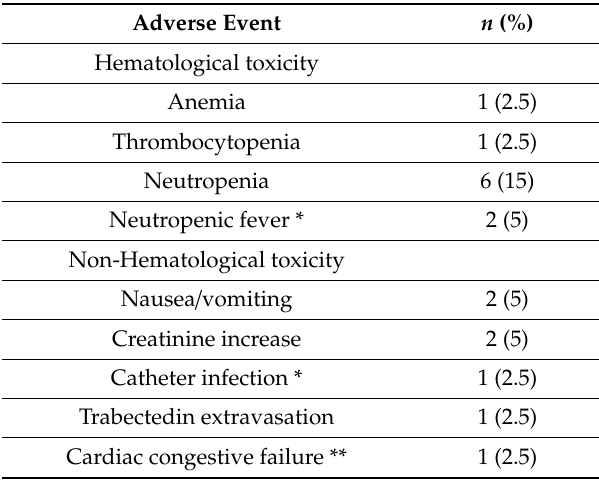
Table 2. Toxicity Grades 3–5 reported in the